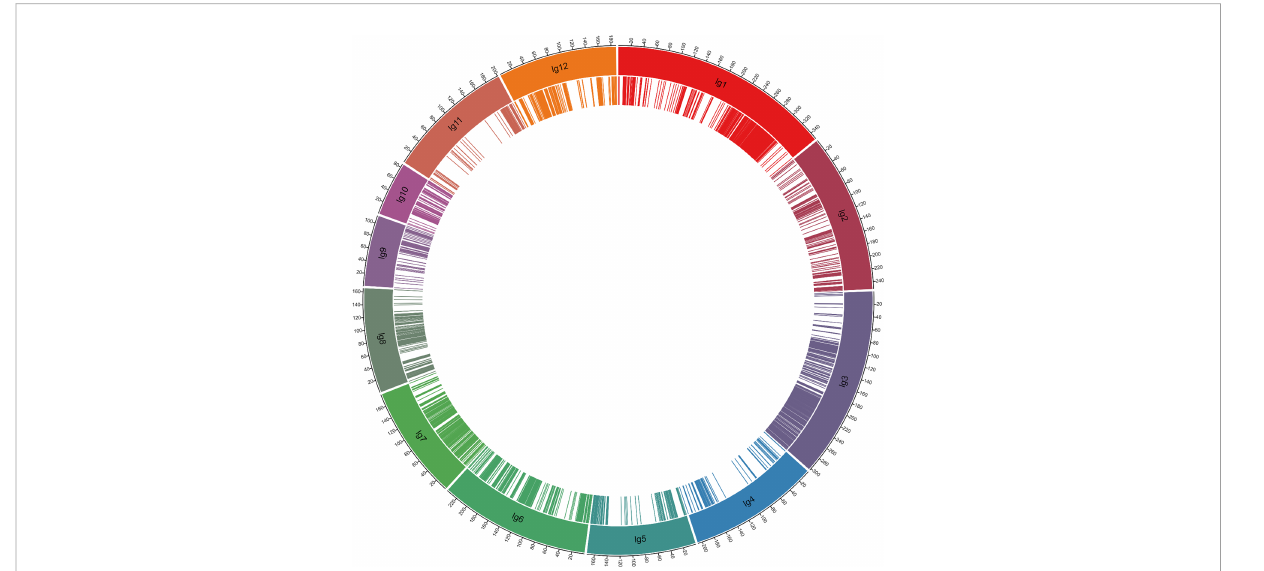
FIGURE 2 High-density genetic map constructed using the genotyping-by-sequencing approach. The genetic distances are expressed in centimorgans (cM). The bin markers ’ position is indicated as bars in the inner